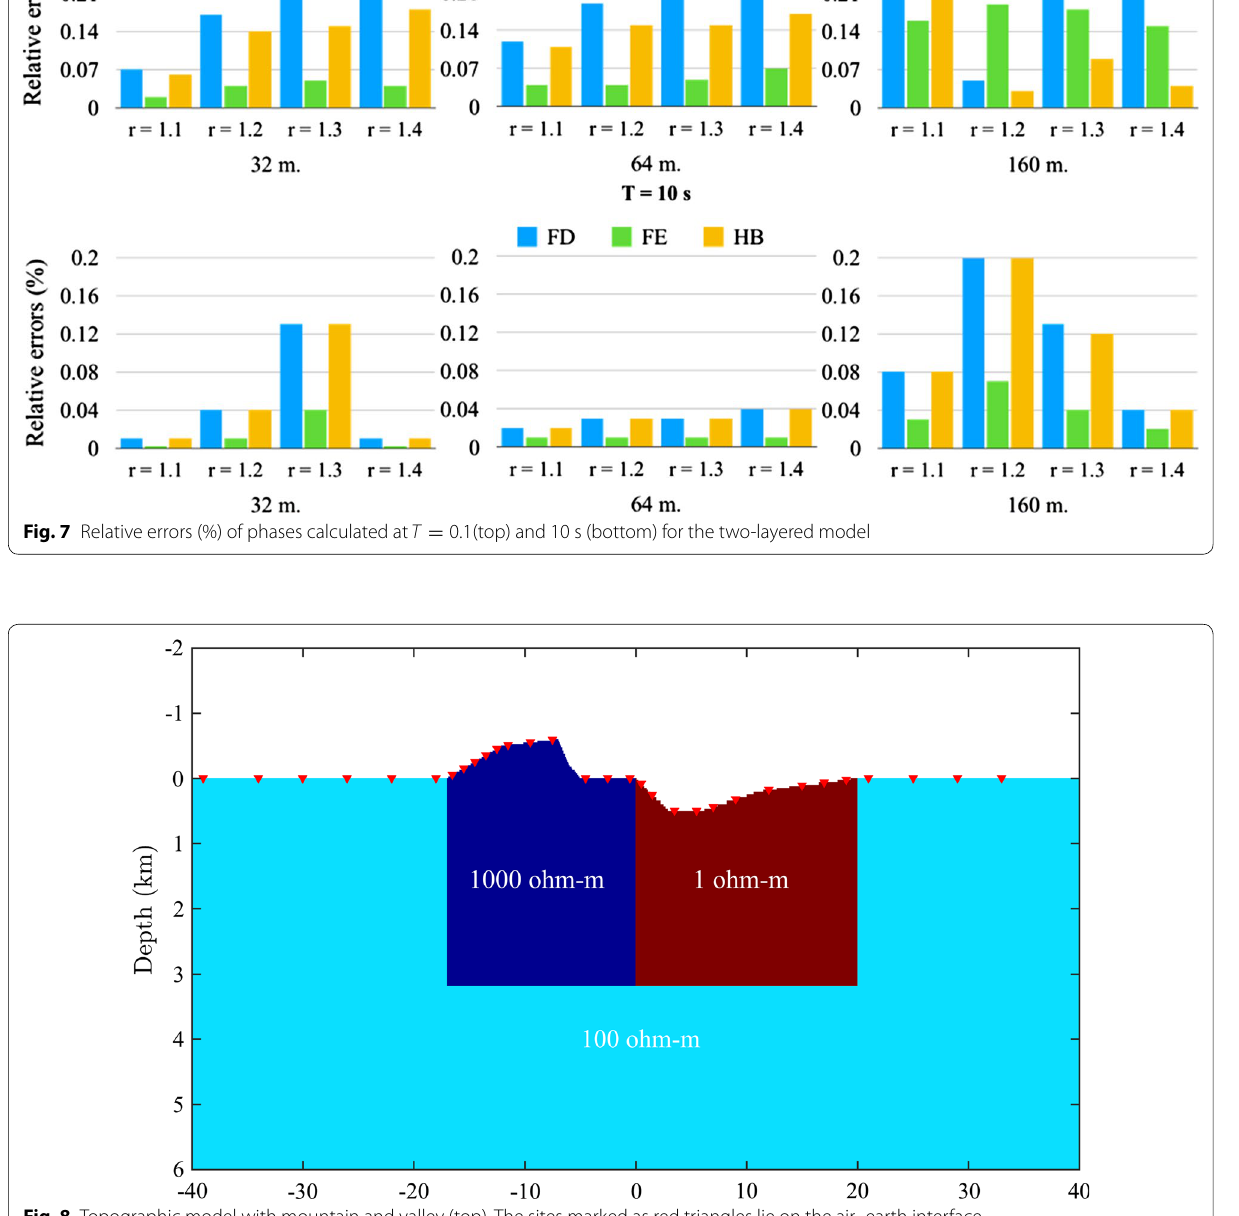
over these topographic zones and some surrounding flat zones. The periods of the EM field used to calculate the × responses are T = 0.1, 1, 10 and 100 s.